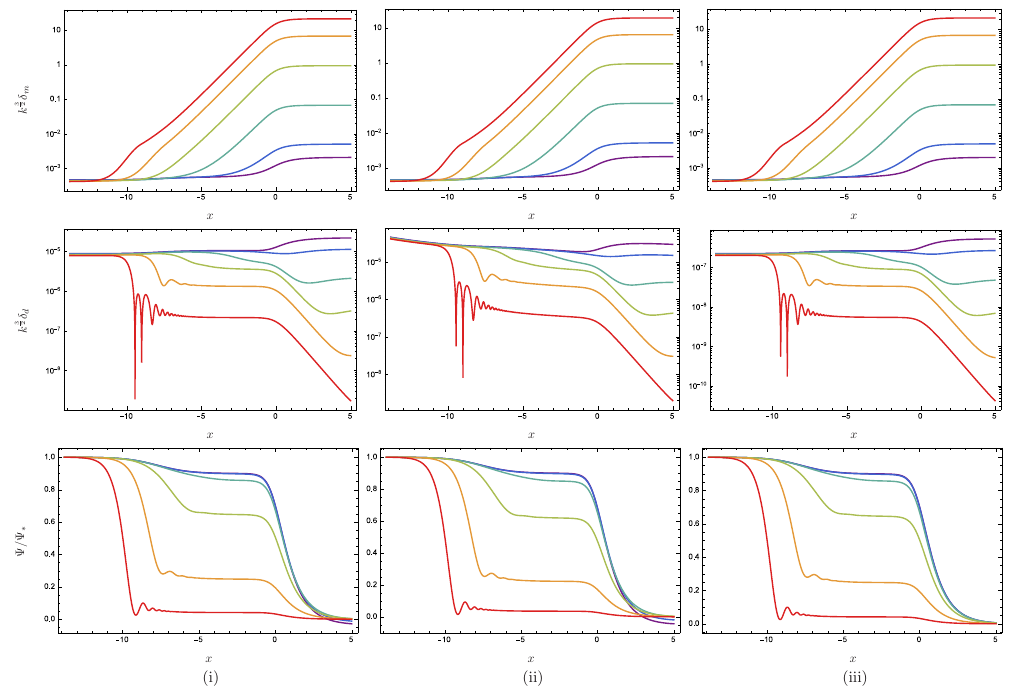
Figure 1. The first, second, and third row of this figure presents the evolution of dark matter (DM), dark energy (DE), and the gravitational potential perturbations, respectively. Each column belongs to a particular model, while each colour represents a mode where the values of the corresponding wave-number are: k = 3.33 × 10 − 4 h · Mpc − 1 (purple); k = 7.93 × 10 − 4 h · Mpc − 1 (dark blue); k = 3.50 × 10 − 3 h · Mpc − 1 (light blue); k = 1.54 × 10 − 2 h · Mpc − 1 (green); k = 6.80 × 10 − 2 h · Mpc − 1 (orange); k = 0.30 h · Mpc − 1